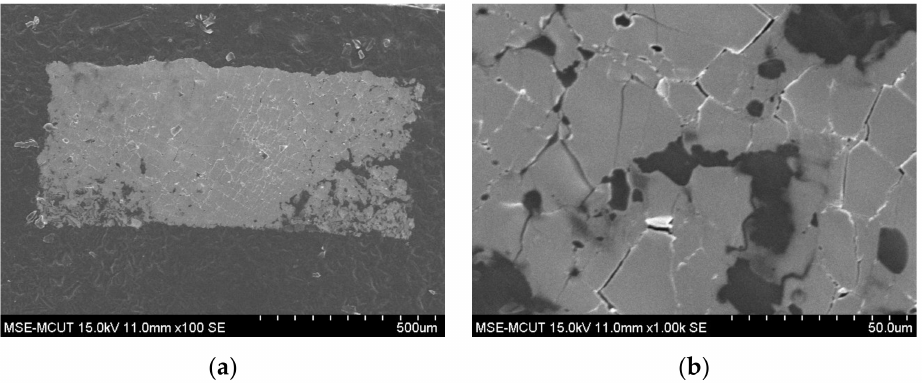
Figure 2. Surface morphology SEM image of inkjet-printed silver film on the wound dressing: ( a ) 100 × and ( b ) 1000 ×